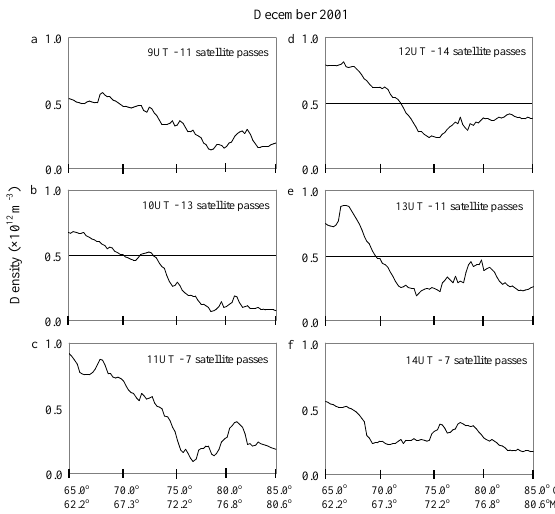
Fig. 3. Median values for the tomography electron densities at the F-region peak under quiet geomagnetic conditions within each one- hour bin between 08:30 UT and 14:30 UT in December